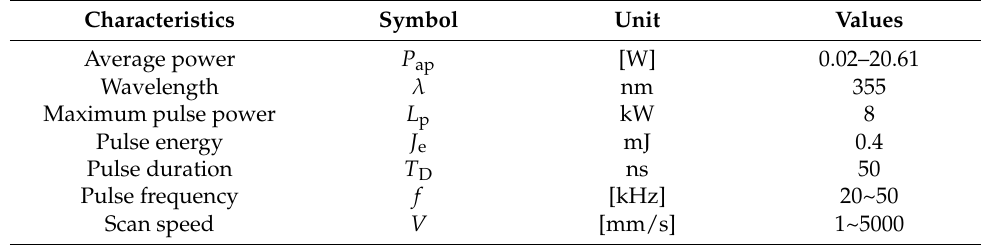
Figure 1. Experimental setup of laser pretreatment. Table 1. Parameters of Nanosecond UV Laser system.